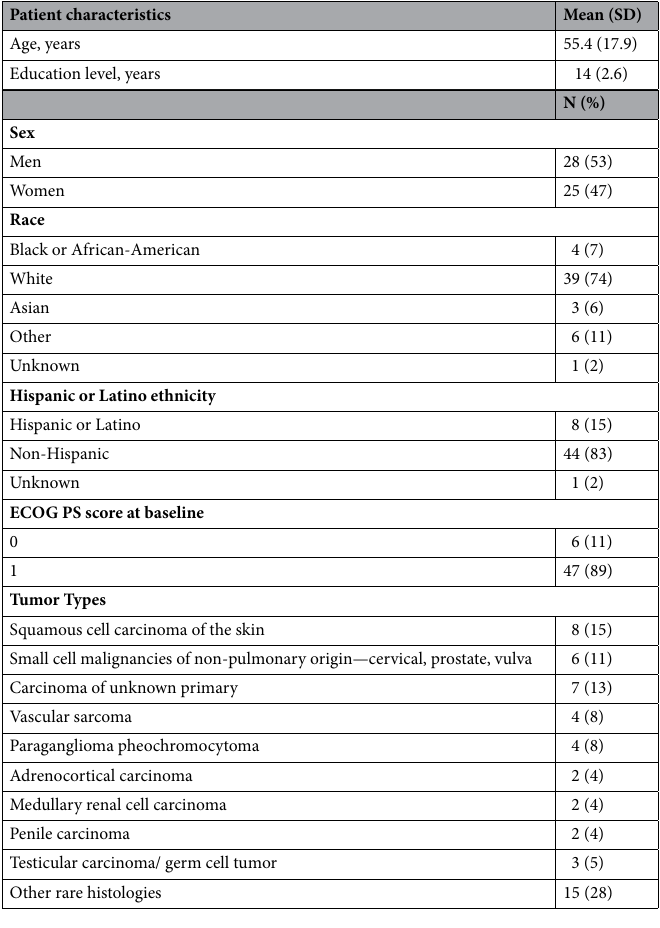
Table 1. Demographic and clinical characteristics of study cohorts ( n = 53). Abbreviations: MDASI- Immunotherapy, immunotherapy module of the M. D. Anderson Symptom Inventory; SD, standard deviation; ECOG PS, Eastern Cooperative Oncology Group performance